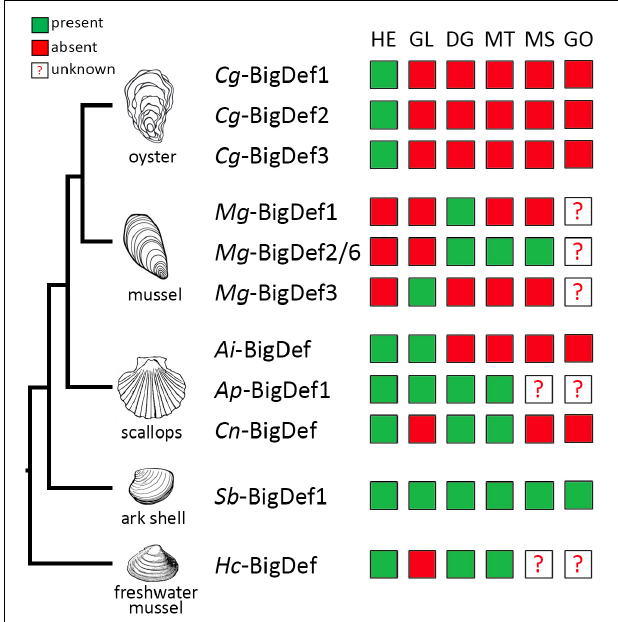
FIGURE 6 | Expression profiles of big defensin genes among different tissues from bivalve mollusks. Big defensin expression in hemocytes (HE), gills (GI), digestive gland (DG), mantle (MT), muscle (MS), and gonad (GO) tissues from the oyster Crassostrea gigas ; the mussel Mytilus galloprovincialis ; the scallops Argopecten irradians, A. purpuratus, and Chlamys nobilis ; the ark shell Scapharca broughtonii and the freshwater mussel Hyriopsis cumingii , is represented in a color code schema. Green squares indicate detection of big defensin transcripts; red squares represent that the expression is undetected. Question mark indicates that the expression in those tissues has not been